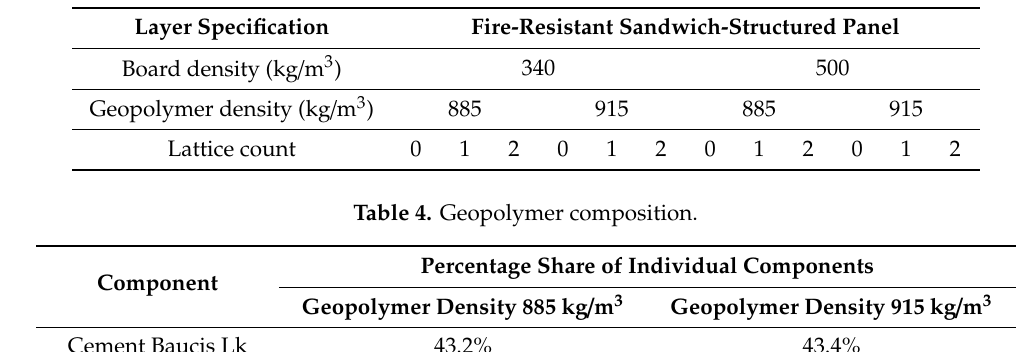
Table 3. Variants of manufactured sandwich-structured panel.